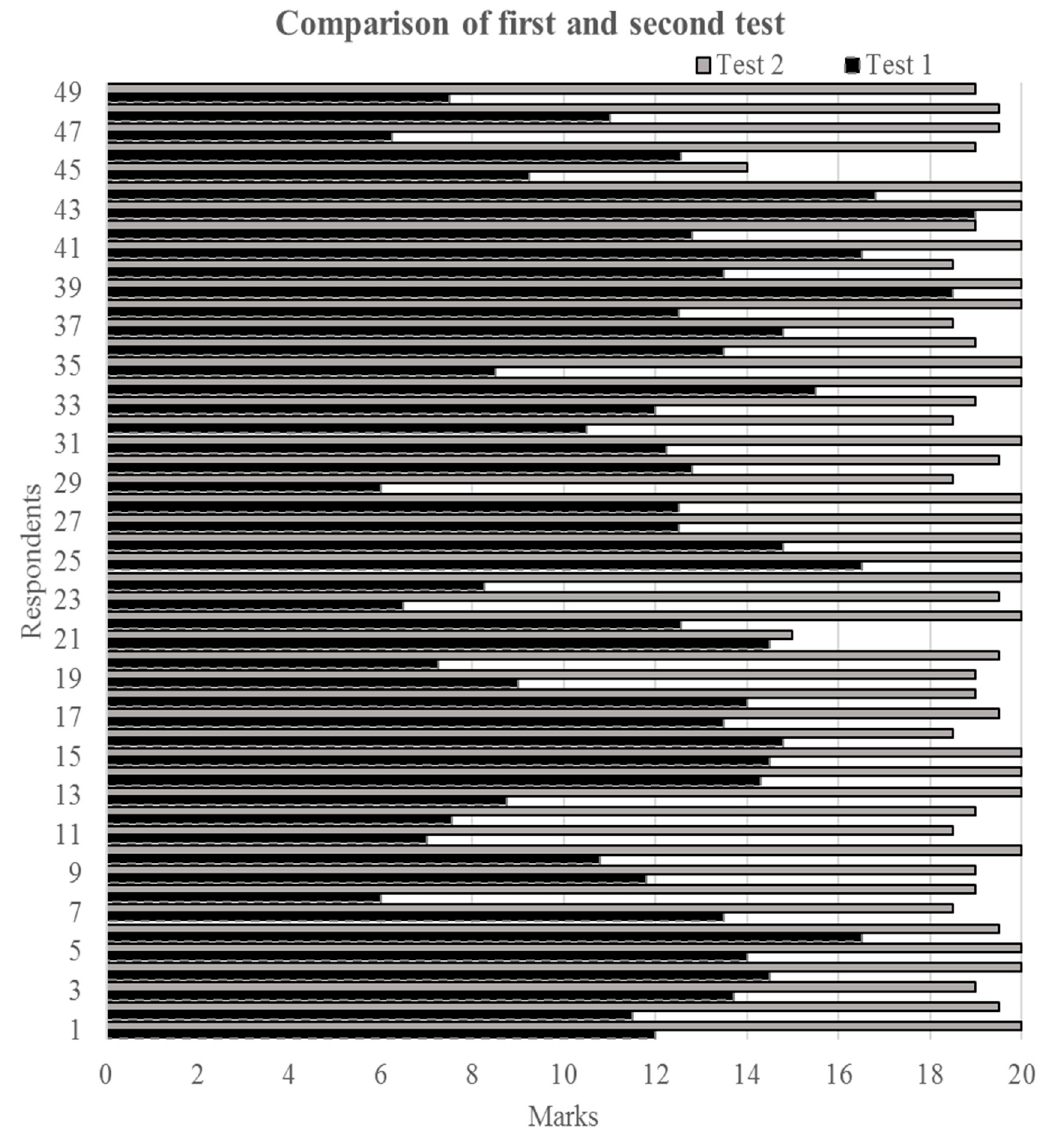
Figure 6. The results for the first and second test.